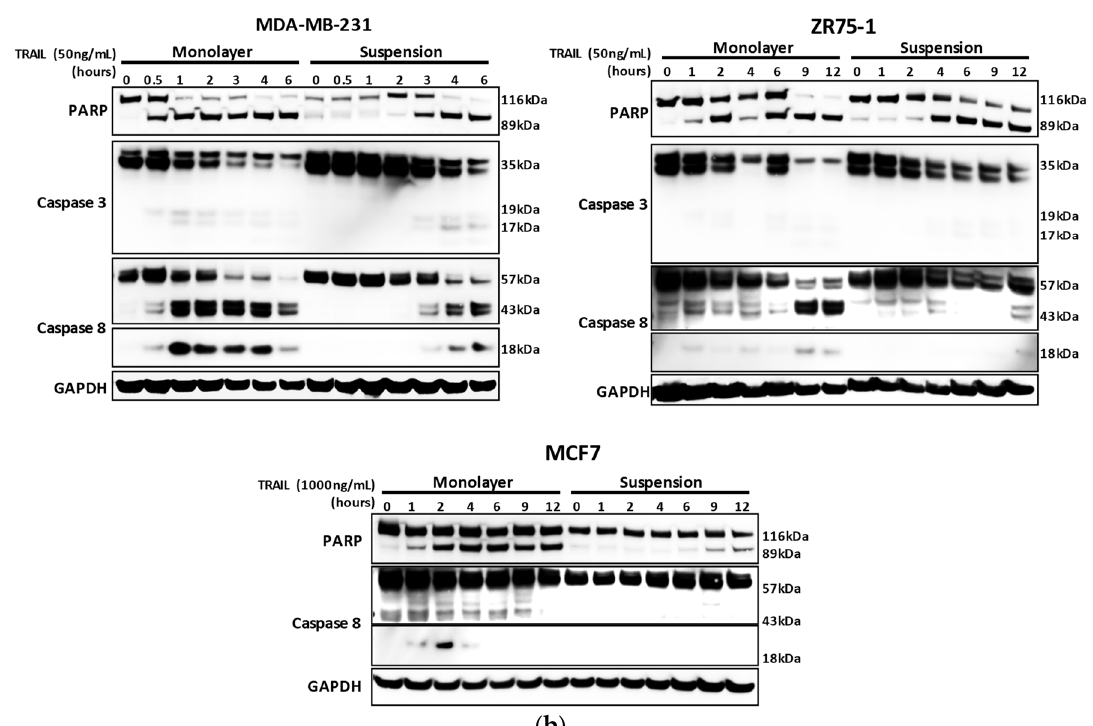
Figure 1. Breast cancer cells cultured under the suspension condition acquire resistance to recombinant human TNF-related apoptosis inducing ligand (rhTRAIL)-induced apoptosis. ( a ) The indicated breast cancer cell lines were cultured under monolayer adherent or non-adherent suspension conditions (see details in Materials and Methods section). Cells were seeded at 10,000 cells per well and were then treated with the rhTRAIL (5 ng/mL and 50 ng/mL for MDA-MB-231 and ZR75-1 cell lines; 100 ng/mL and 1000 ng/mL for MCF7 cell lines reflecting the previously determined IC50 to rhTRAIL treatment [37]), over 24 h. Relative viability was measured at hour intervals, using an MTT assay, and was normalized to the non-treated controls. Values are means ± SEM of triplicates. (* p < 0.05 monolayer culture relative to suspension at same time point with rhTRAIL treatment of 5 ng/mL for MDA-MB-231 and ZR75-1 or 100 ng/mL for MCF7 cells; + p < 0.05 monolayer culture relative to suspension at same time point with rhTRAIL treatment of 50 ng/mL for MDA-MB-231 and ZR75-1, or 1000 ng/mL for MCF7 cells; n = 3). ( b ) Western blot analysis of caspase and PARP cleavage following the rhTRAIL treatment.